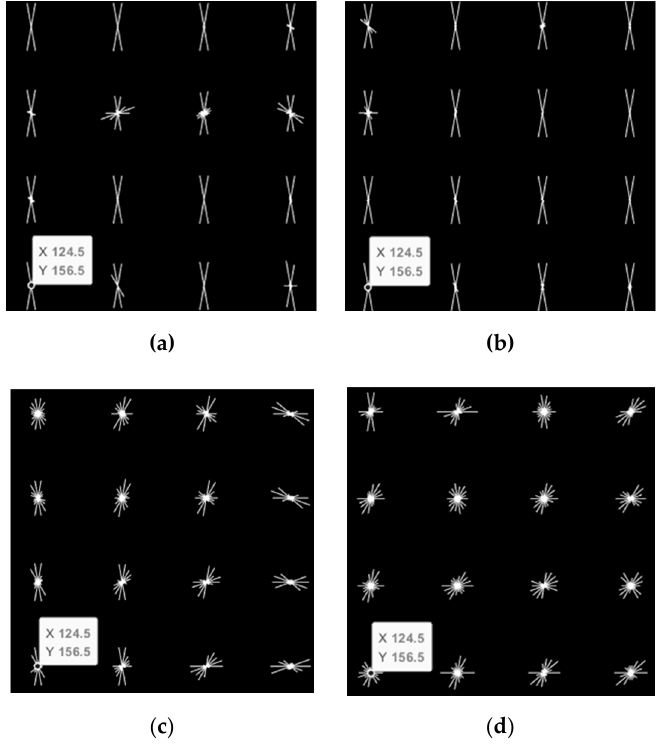
Figure 7. Local visualization of the HOG feature extracted from a 3D PRPS graph: ( a ) result of free metal particles defect; ( b ) result of suspended electrode defect; ( c ) result of metal tip defect; ( d ) result of air gap defect.